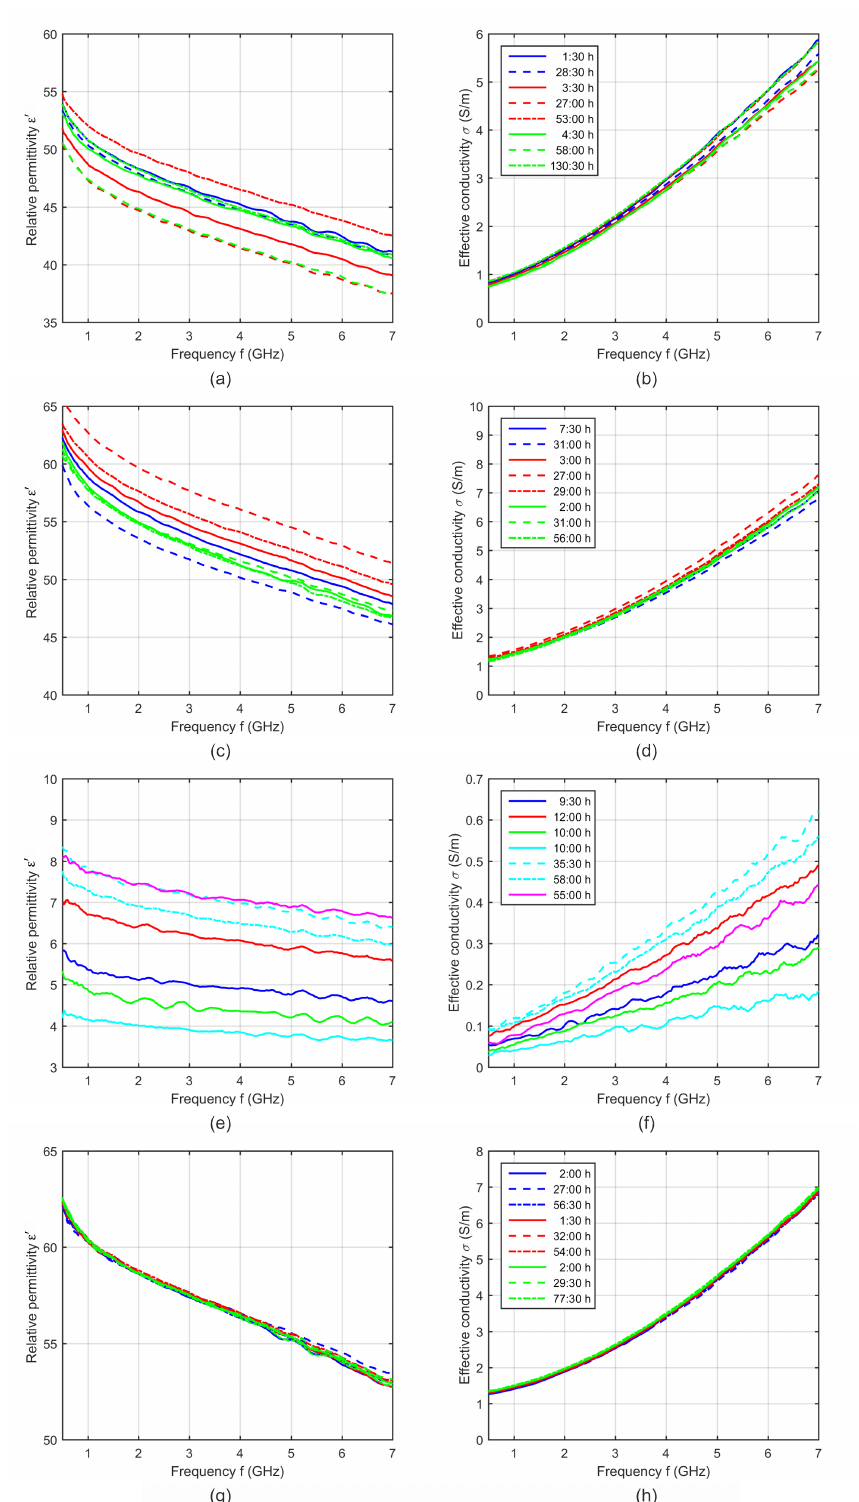
Figure 3. Relative permittivity and effective conductivity of ( a , b ) porcine liver, ( c , d ) muscle, ( e , f ) fat and ( g , h ) blood at 37 ◦ C as a function of frequency for different storage times. Each curve shows the dielectric properties of one sample, whereby curves of the same color indicate samples of the same